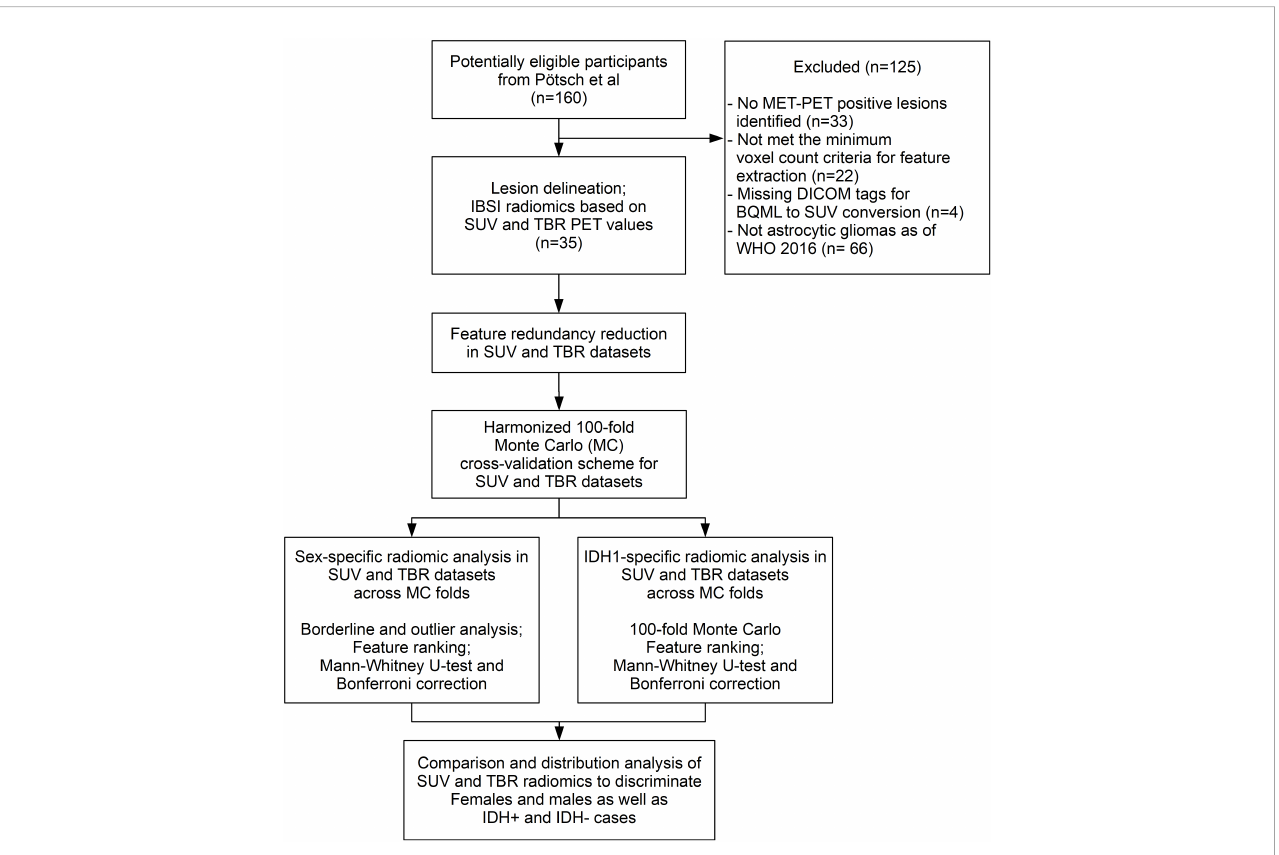
FIGURE 1 The CONSORT diagram of our study. The Methionine (MET) positive Positron Emission Tomography (PET) cases that met the inclusion criterion underwent lesion delineation and radiomics feature extraction as of the Imaging Biomarker Standardization Initiative (IBSI) guidelines in both standardized uptake value (SUV) and tumor-to-background ratio (TBR) PET con fi gurations. Feature redundancy reduction was followed by aligned 100- fold Monte Carlo (MC) split of SUV and TBR dataset pairs for sex and IDH+/- labels independently. Borderline and outlier scores followed by identifying sex-speci fi c high-ranking radiomic features were done in both SUV and TBR radiomic datasets. The same analysis was performed in parallel to differentiate IDH1+/- cases. Comparison of high-ranking features as well as feature distribution analysis was performed independently in IDH+ and IDH- male and female cases to understand if IDH predictability is associated with sex-speci fi c radiomic patterns in